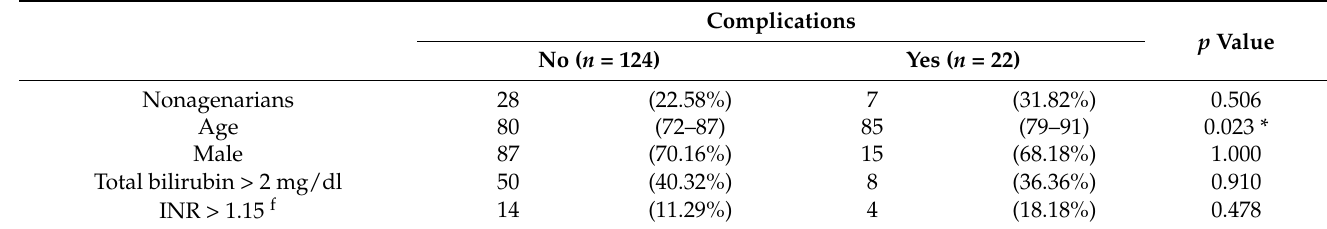
Table 2. Patients who suffered from complications versus those who did